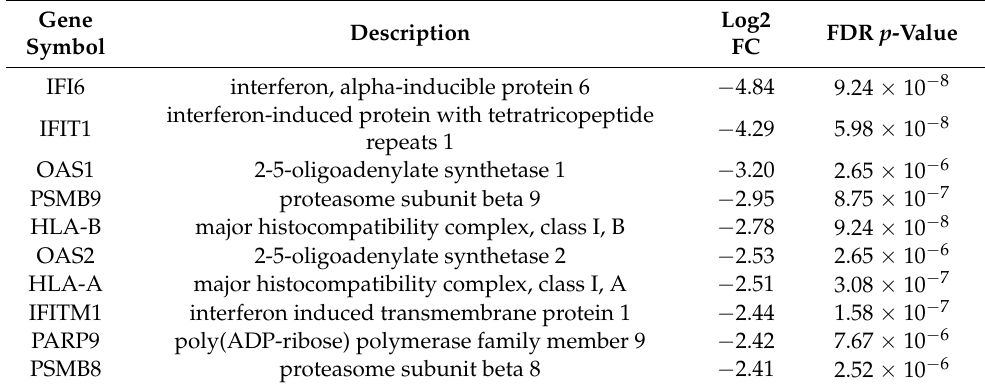
Table 2. Top ten downregulated genes in spheroids transfected with miR193a.